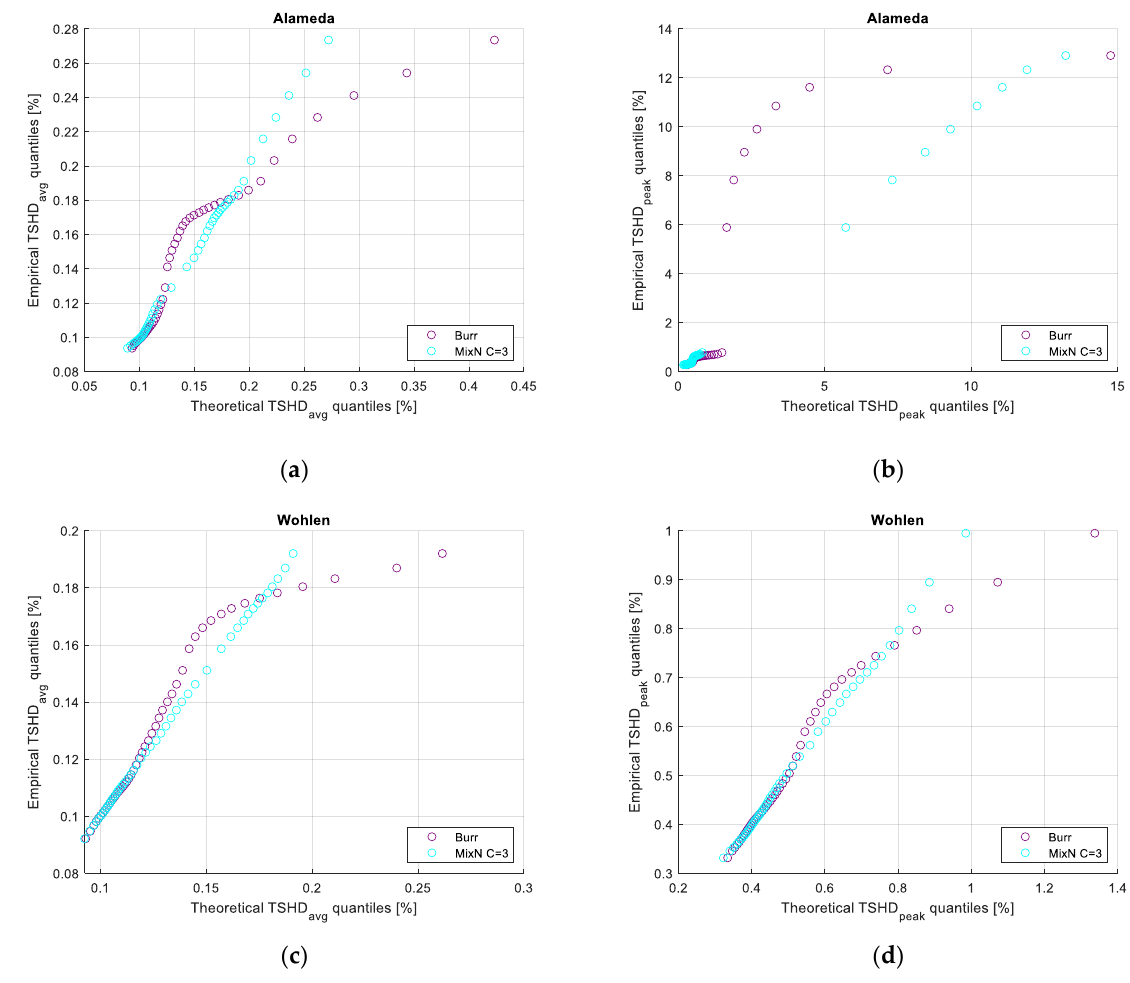
Figure 2. Q-Q plots of the: ( a ) TSHD avg at Alameda (CA); ( b ) TSHD peak at Alameda (CA); ( c ) TSHD avg at Wohlen (Swizterland); ( d ) TSHD peak at Wohlen (Swizterland).